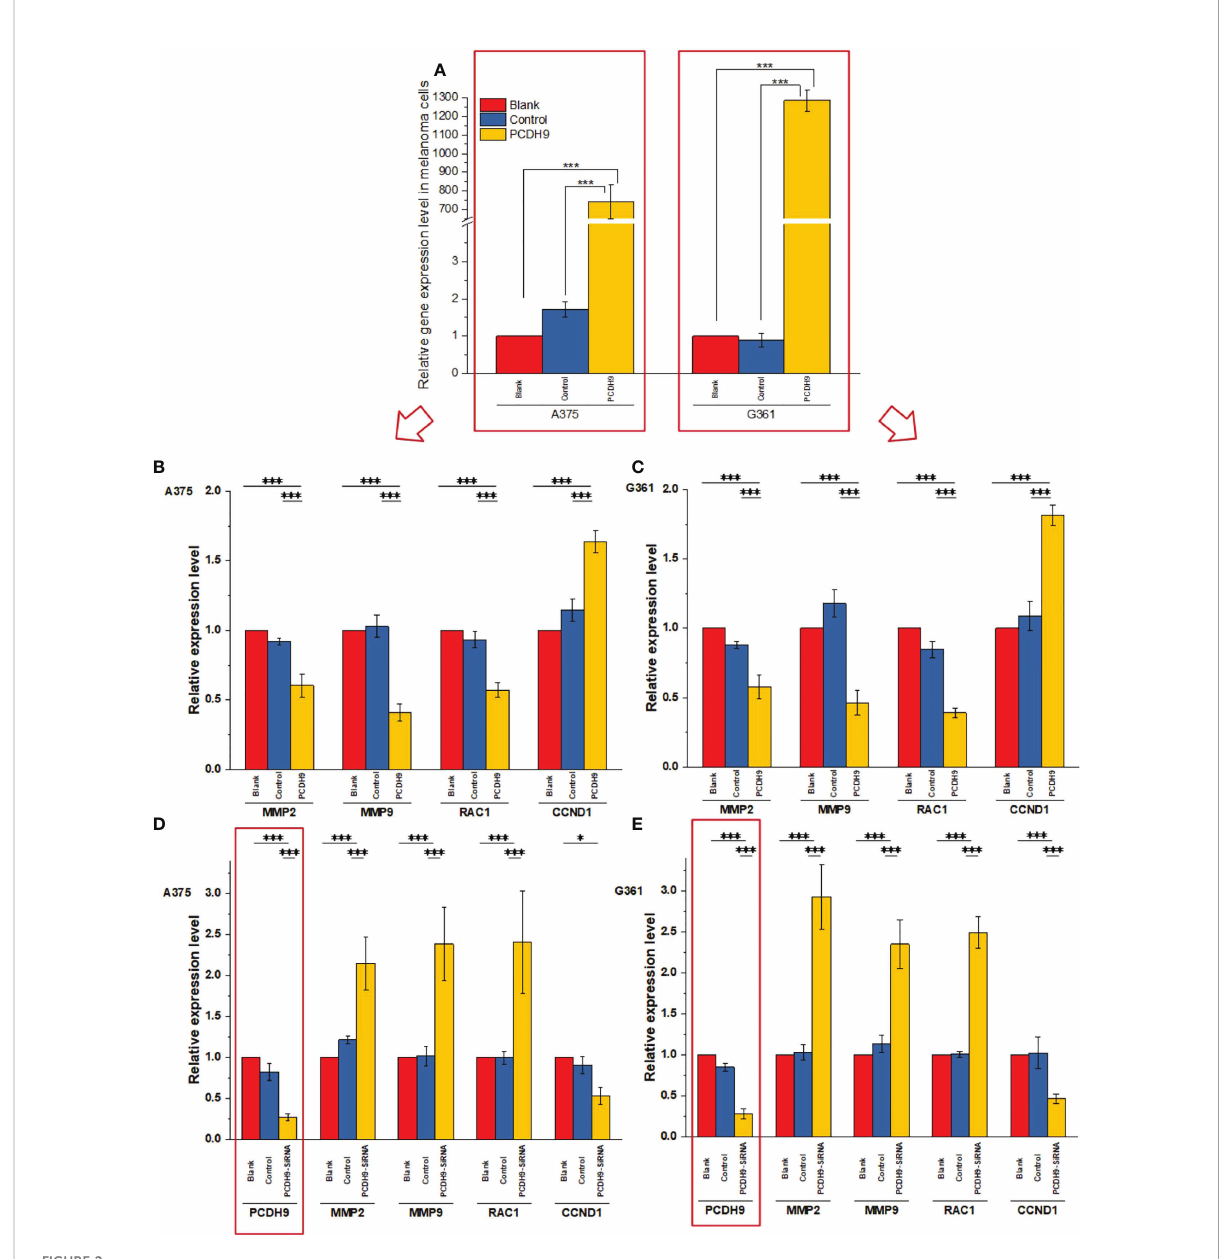
FIGURE 2 Effects of overexpressed and interfered PCDH9 in melanoma cells measured by PCR analysis (A) . The expressions of PCDH9 were signi fi cantly upregulated by lentivirus infection. Overexpressed PCDH9 signi fi cantly upregulated CCND1 and downregulated RAC1 and MMP9 in both cells [A375 (B) and G361 (C) ]. Interfered PCDH9 downregulated CCND1 and upregulated RAC1 and MMP2 in both cells [A375 (D) and G361 (E) ]. * p < 0.05, and *** p < 0.001 compared in groups by using one-way ANOVA followed by least signi fi cant difference post hoc